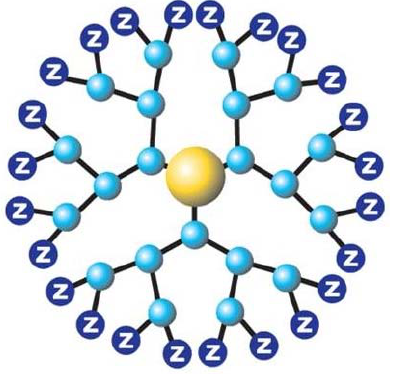
Figure 2. Dendrimer structure.